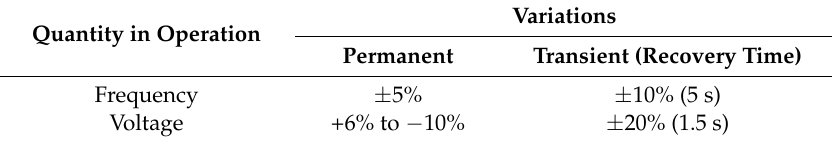
Table 3. Acceptable ranges of voltage and frequency variations in ac distribution